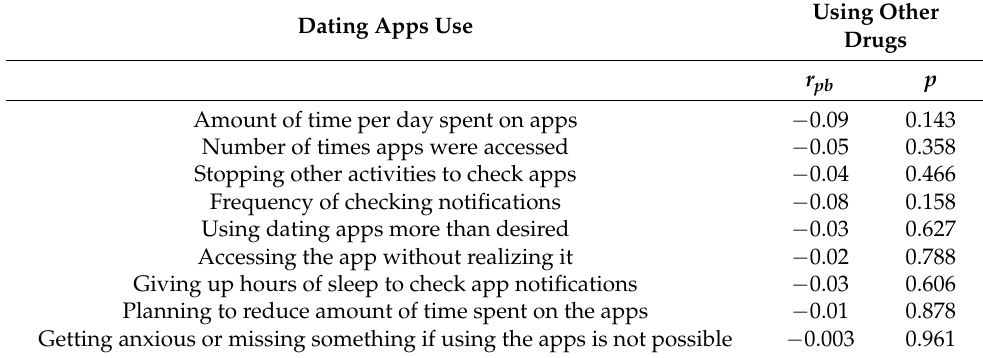
Table 6. Point-biserial correlations ( r pb ) testing the association between hard drug use and the variables related to dating app use in the sample of active